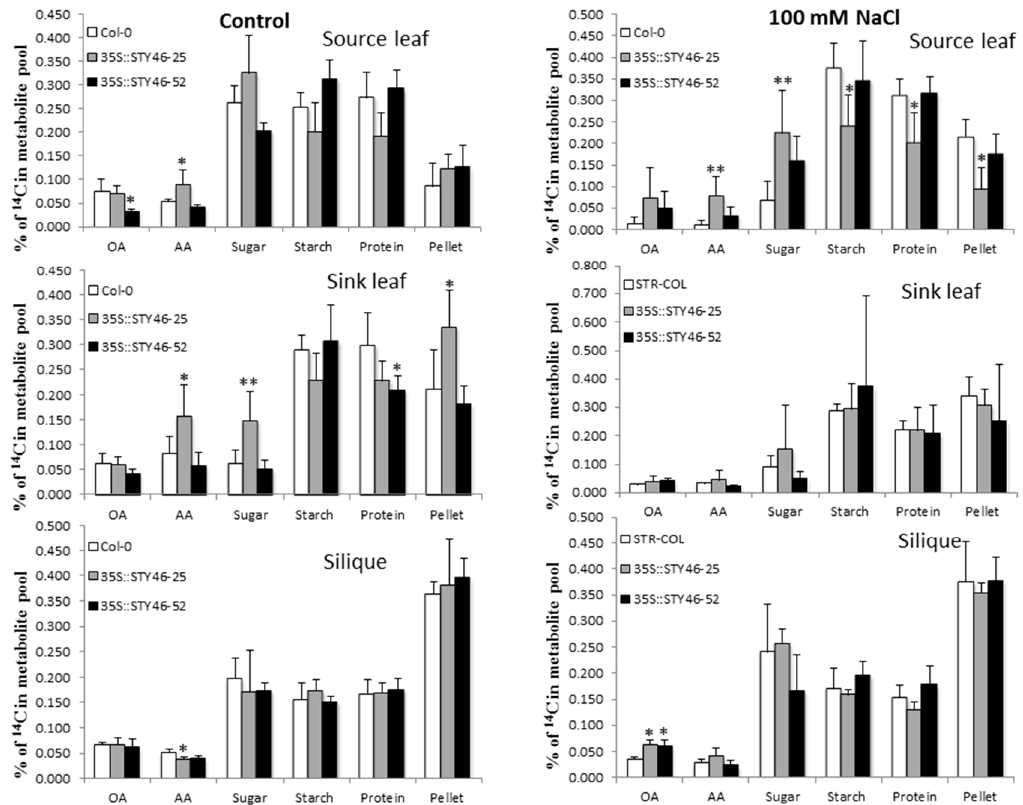
Figure 8 . 14 C partitioning in Arabidopsis source and sink tissues under normal and salinity stress. The incorporation of 14 C into sugars, starch, amino acids (AA), protein, organic acids (OA), and pellets in the source leaf, sink leaves, and silique at midday was determined. The total label in each tissue was set to 100%. The asterisks indicate a significant difference between the control and salt-treated plants ( n = 5, p < 0.05).